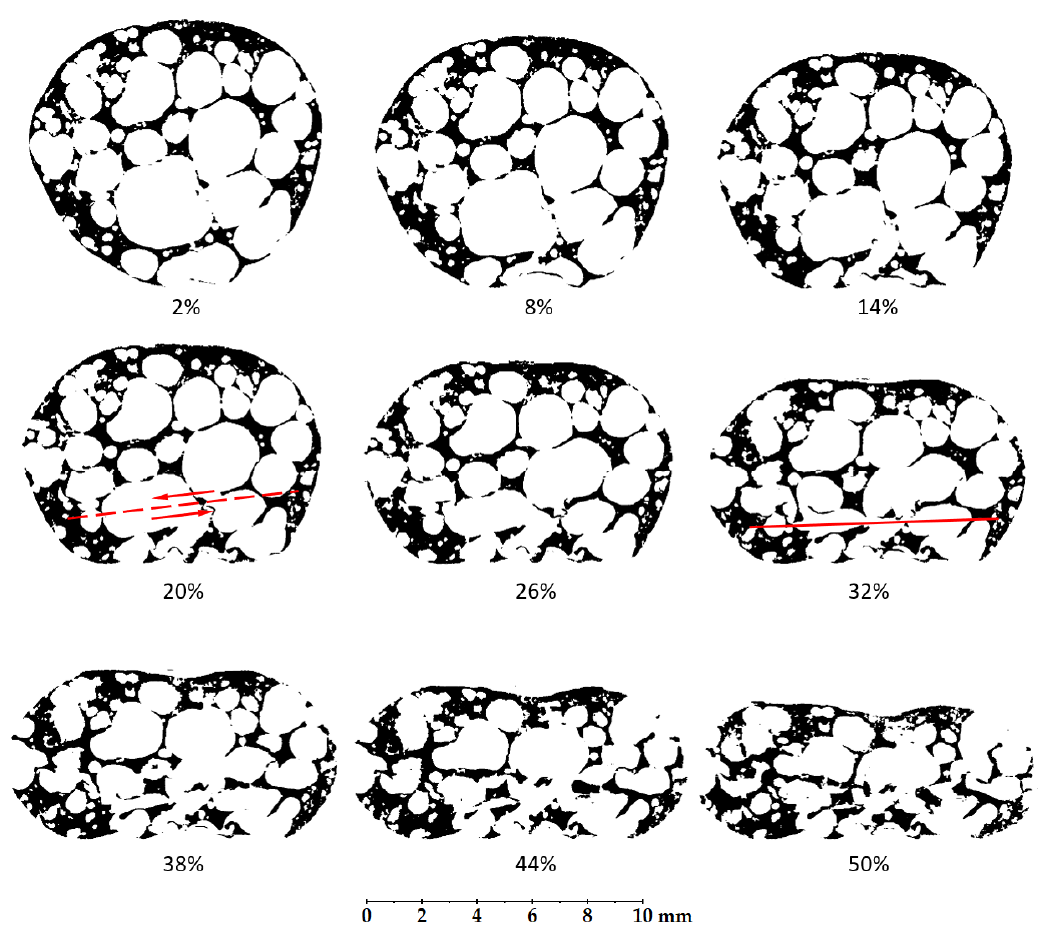
sample 1 in dependence on the sample height in a grey colour with a deformation step of 2%. The black lines represent the values of the filled radii at 26% and 50%. The results show that the undeformed shape of the samples is close to a spherical shape and that the undeformed sample heights are equal to 10.0, 9.73 and 10.1 mm, while the maximum undeformed filled radii are equal to 5.35, 5.22 and 5.31 mm for samples 1, 2 and 3, Figure 10. Lateral cross-sections of the APM foam sample 1 at deformation levels from 2% to 50%. respectively.